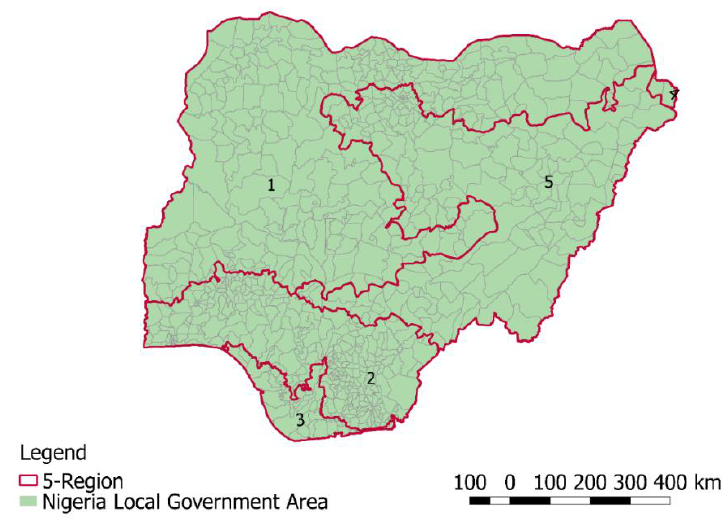
Figure 12. Five regions scenario developed using the “regionalization with dynamically constrained agglomerative clustering and partitioning” (REDCAP) technique.